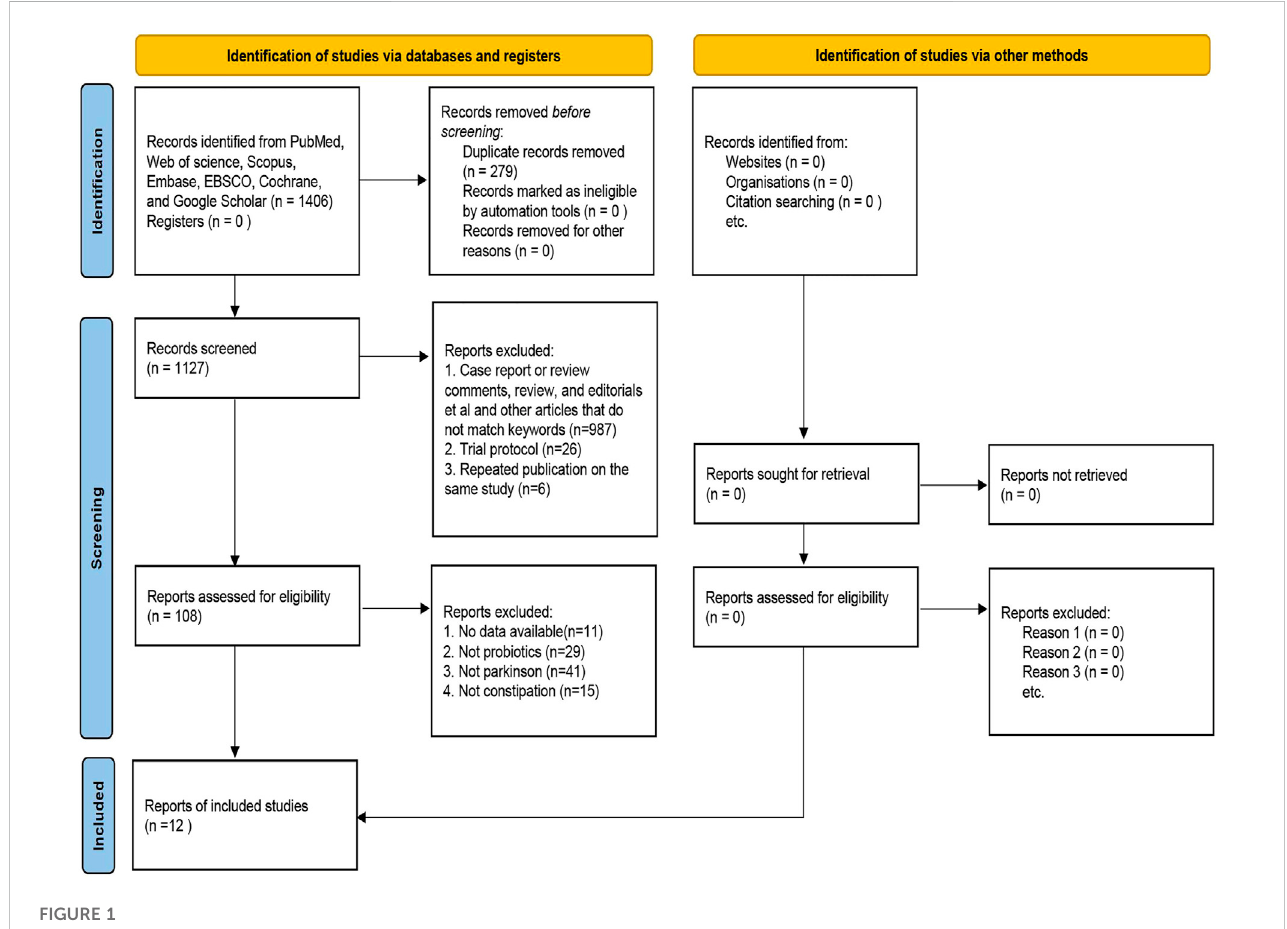
FIGURE 1 Flow chart of literature retrieval and